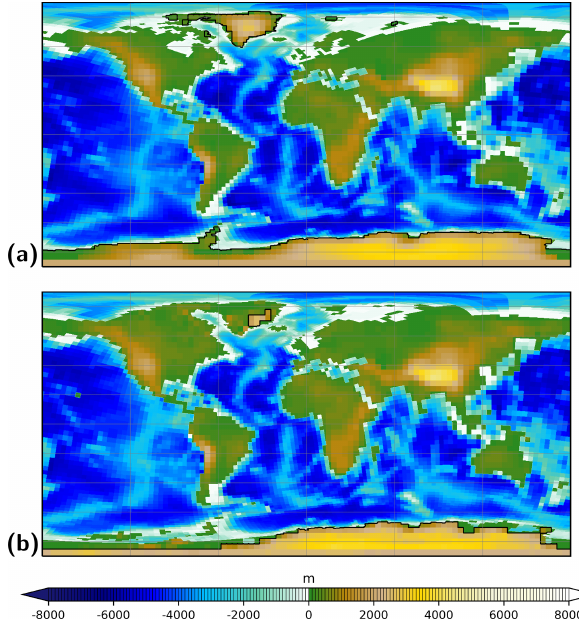
Figure 2. Model setup of COSMOS PlioMIP2 core simulations for (a) pre-industrial and (b) mid-Pliocene geography. Shown are bathymetry (dark blue to white shading), land topography (green to white shading), and the extent of ice sheets (black contours). From this setup sensitivity simulations of the PlioMIP2 simulation ensem- ble are